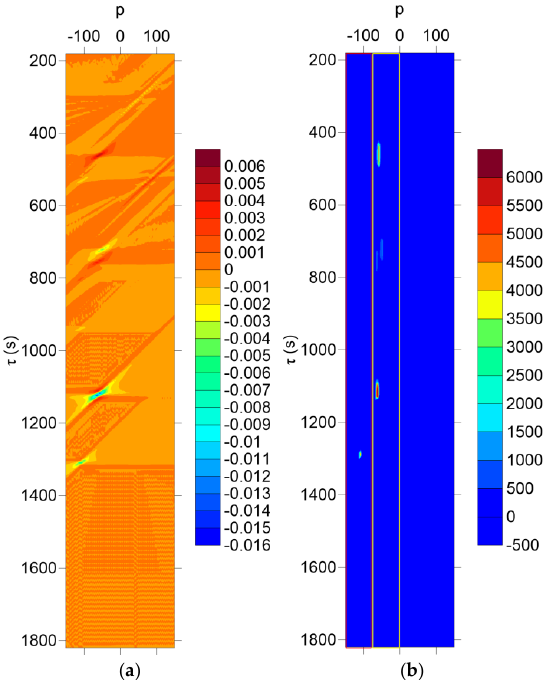
Figure 8. The results for the ( a ) traditional and ( b ) modified linear Radon transform based on the VSP data after subtraction of the downgoing wavefields in the original synthetic VSP records. Appl. Sci. 2018 , 8 , x FOR PEER REVIEW